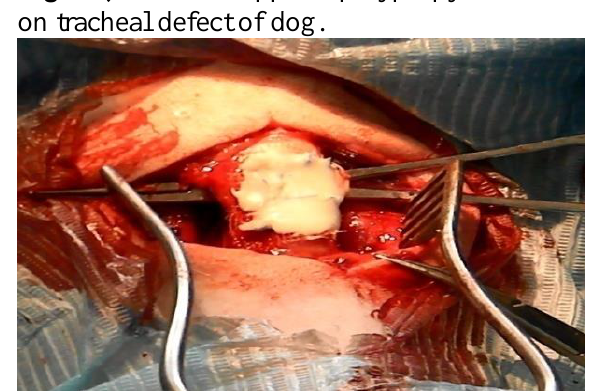
Figure, 3: Shows tracheal defect of dog in G1 were covered by polypropylene mesh and bone cement.